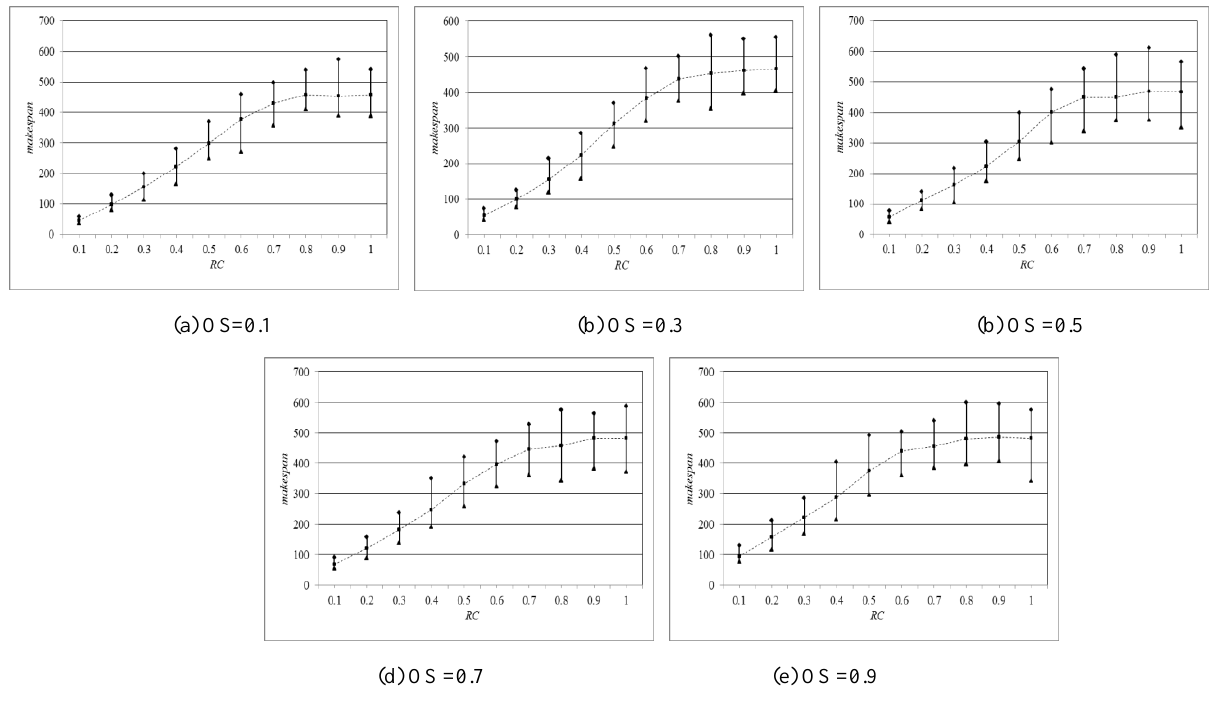
Fig.12 The impact of RC on the makespan